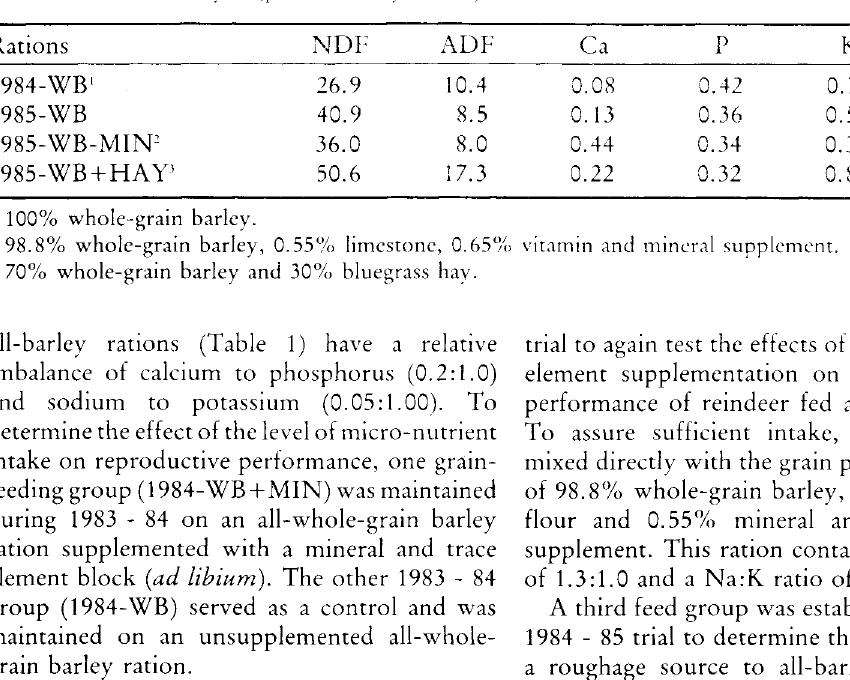
Table 1. Nutrient analysis (percent of dry-matter) of rations